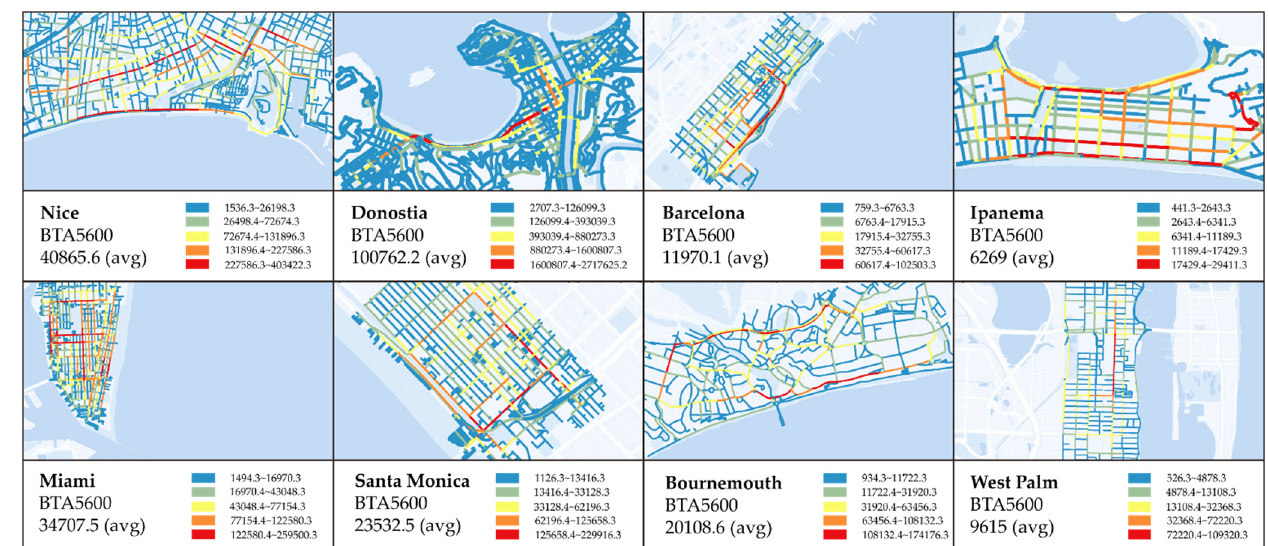
Figure 6. The analytical results of BTA 5600 in successful coastal cases.